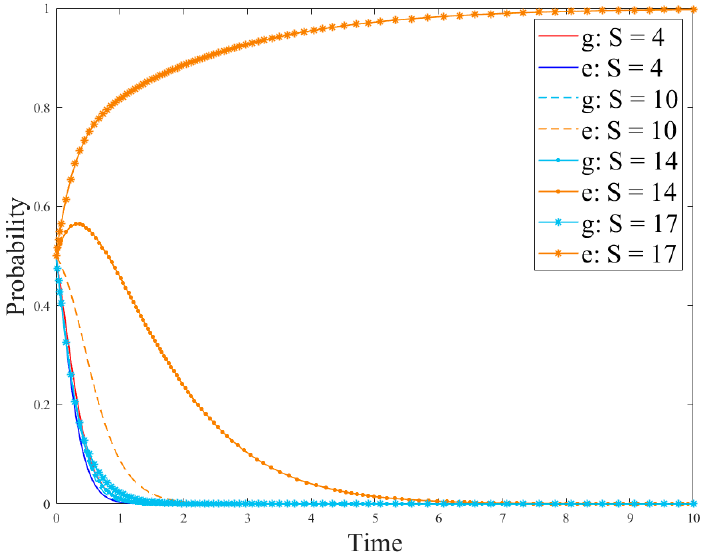
Figure 3. Evolution process of the government ( g ) and enterprises ( e ) with different government